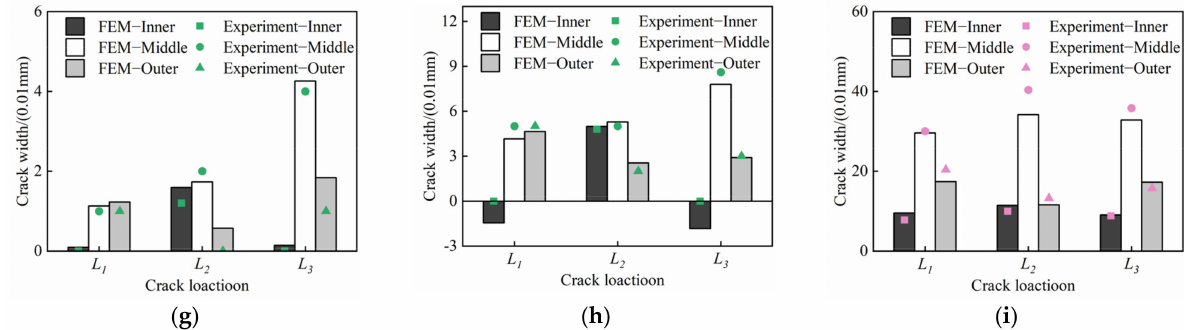
Figure 15. Crack widths under finite element model and test model subjected to different temperature gradients: ( a )A1; ( b ) A2; ( c ) A3; ( d ) B1; ( e )B2; ( f ) B3; ( g ) C1; ( h ) C2; ( i ) internal water pressure.